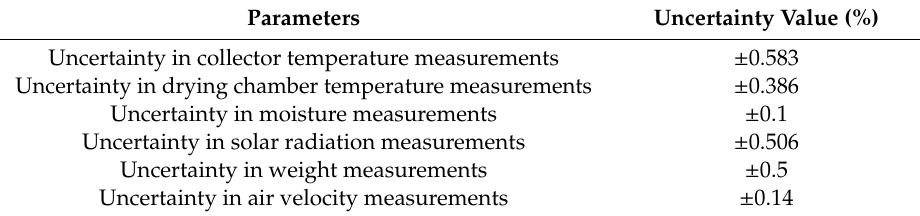
Table 3. Uncertainty Analysis